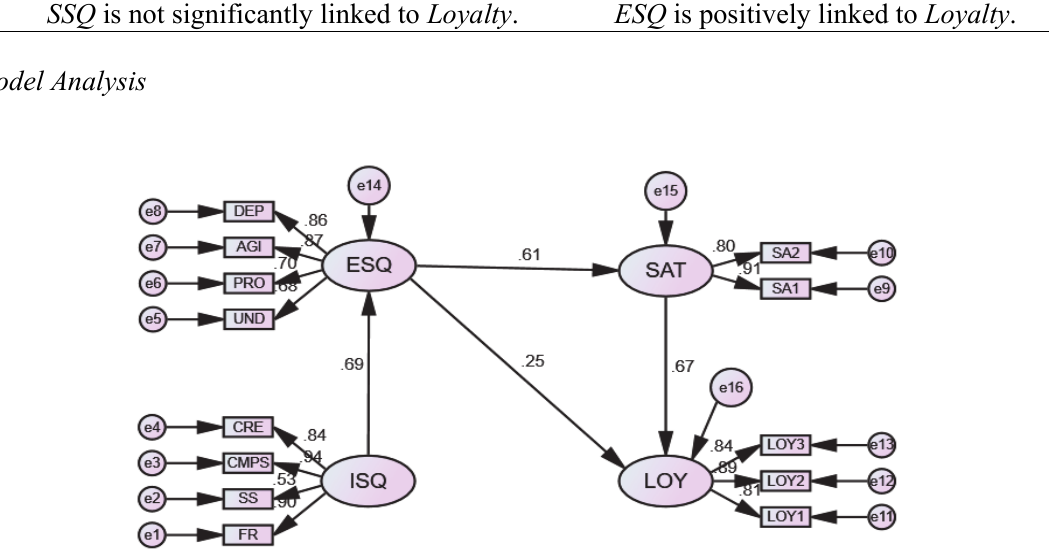
Fig. 5. Path estimates of